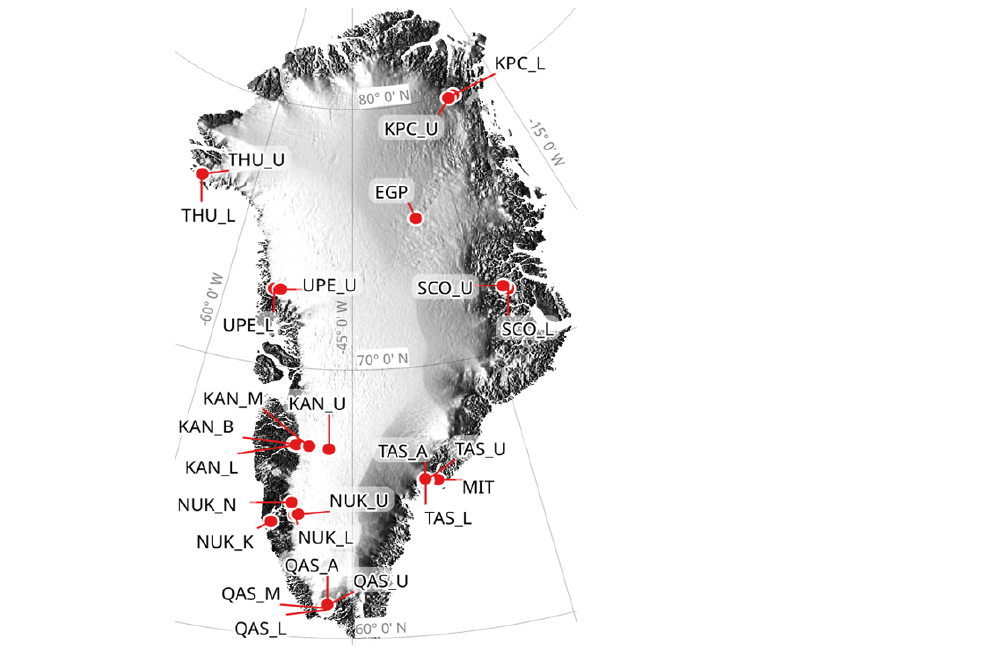
Figure 4. Map of Greenland showing the location of the PROMICE automatic weather stations (AWS) [52] .